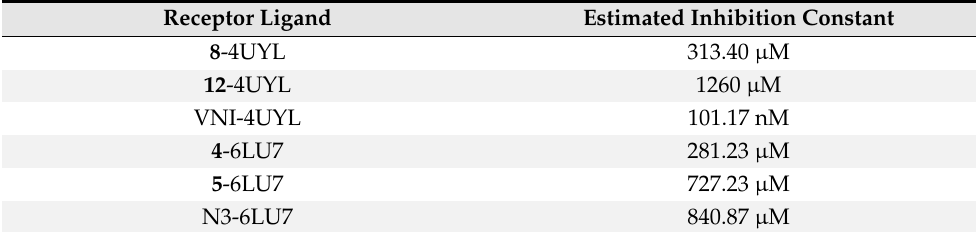
Table 7. Ki of 4 , 5 , 8 , 12 , VNI, and N3 with receptor protein(s). Receptor